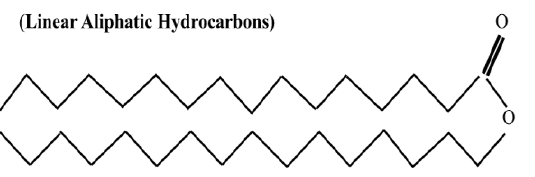
Figure 2. Chemical structure of paraffin (linear aliphatic hydrocarbons) [40].